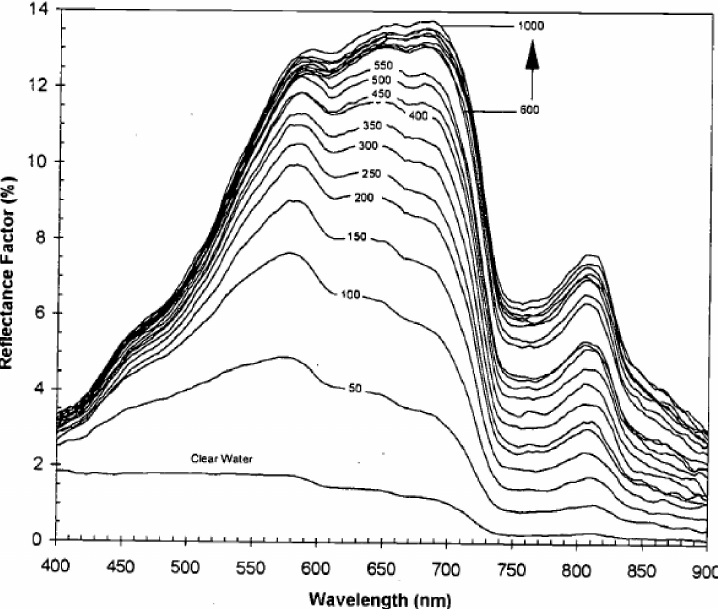
Figure 4. Reflectance for water with a dusty suspension [g/m 3 ]. Reprinted with permission from [18].